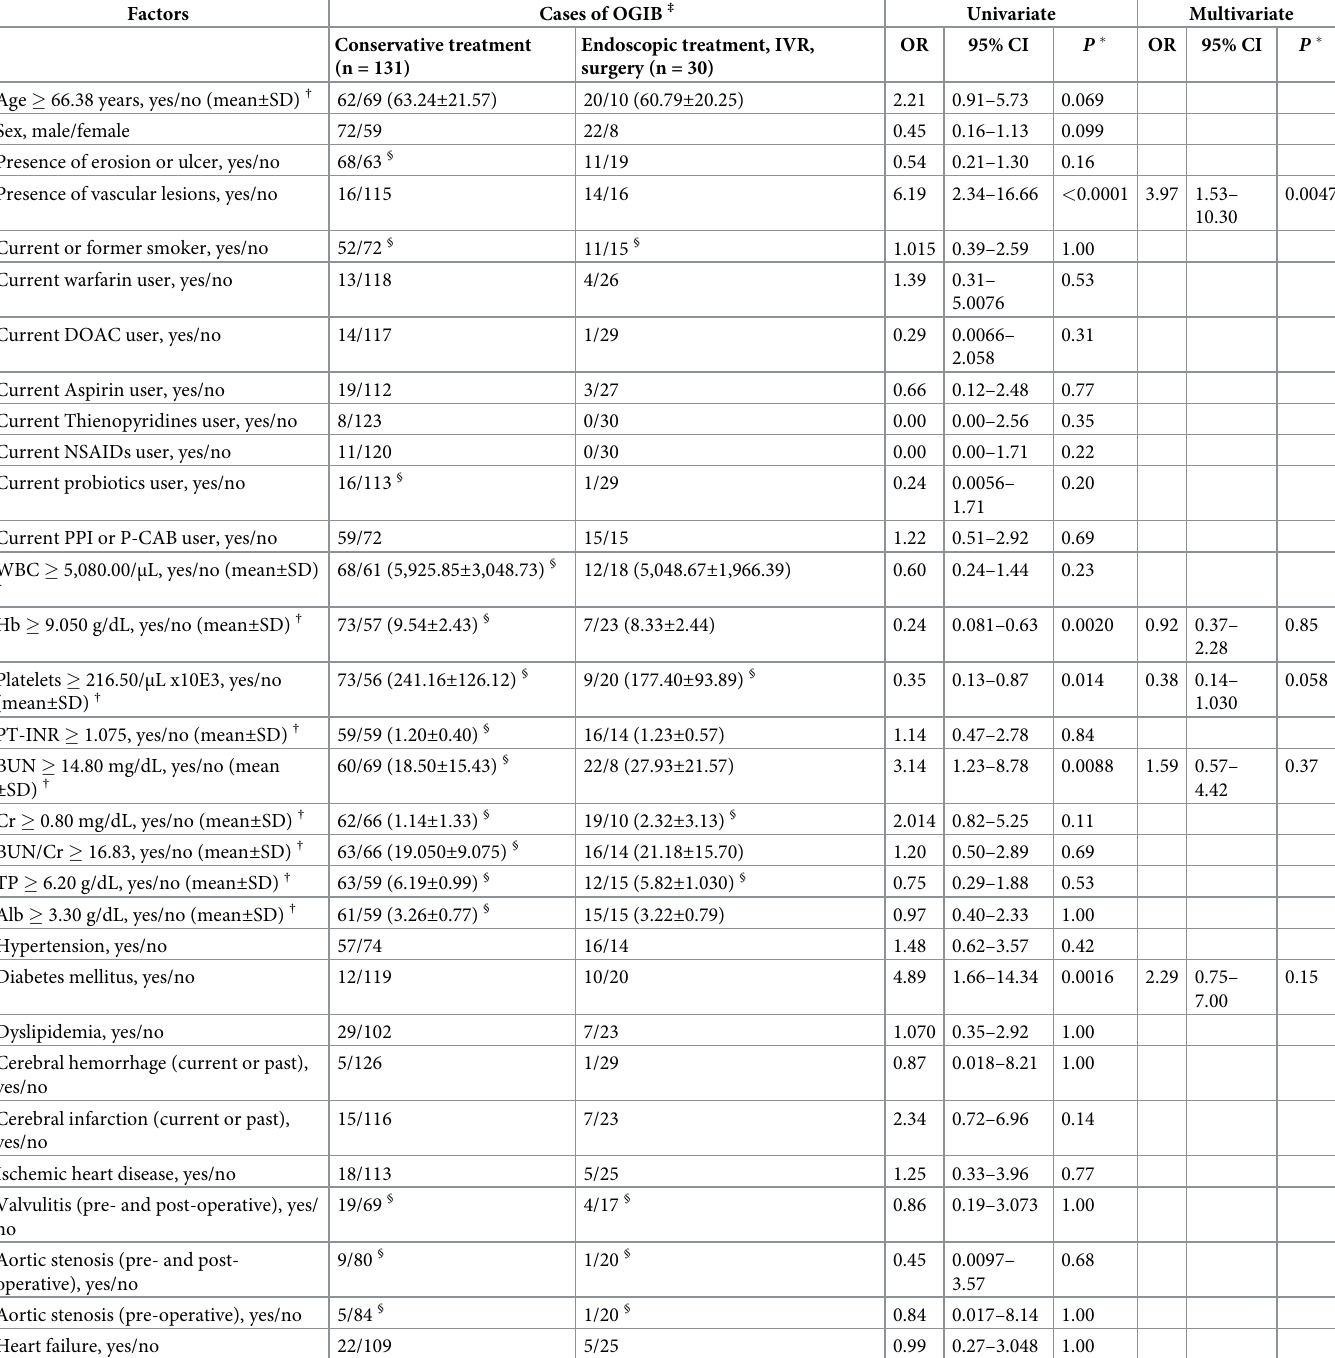
Table 4. Comparison of clinical features of cases of obscure gastrointestinal bleeding receiving different treatments, identified by univariate and multivariate analysis.